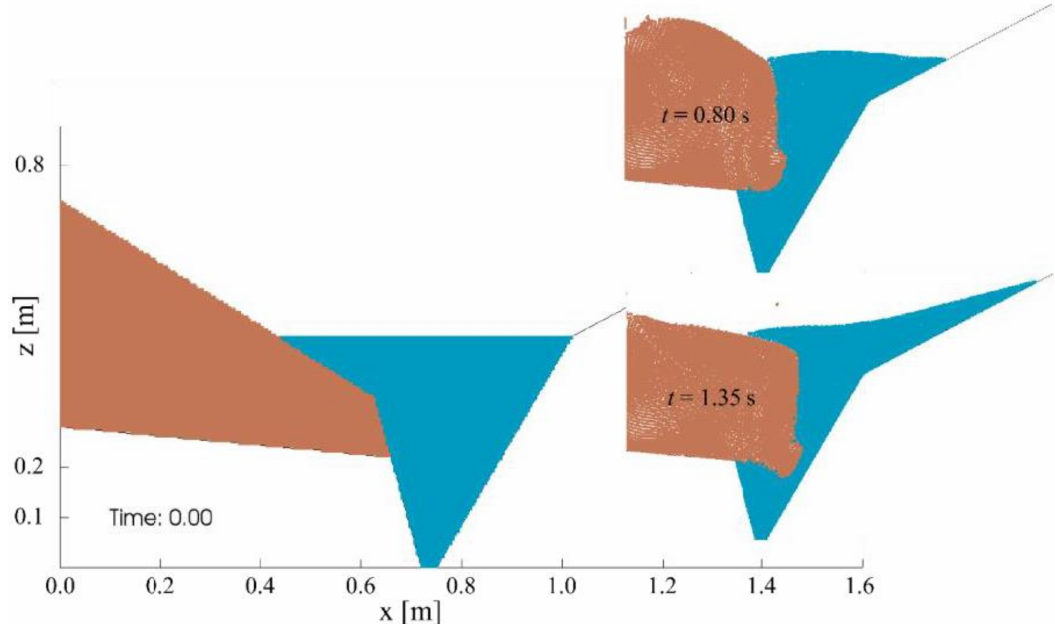
Figure 6. ( Left ) Sketch of the landslide toe and stored water from the Padua experiment; and ( Right ) frames at some significant time instants (ref. Run